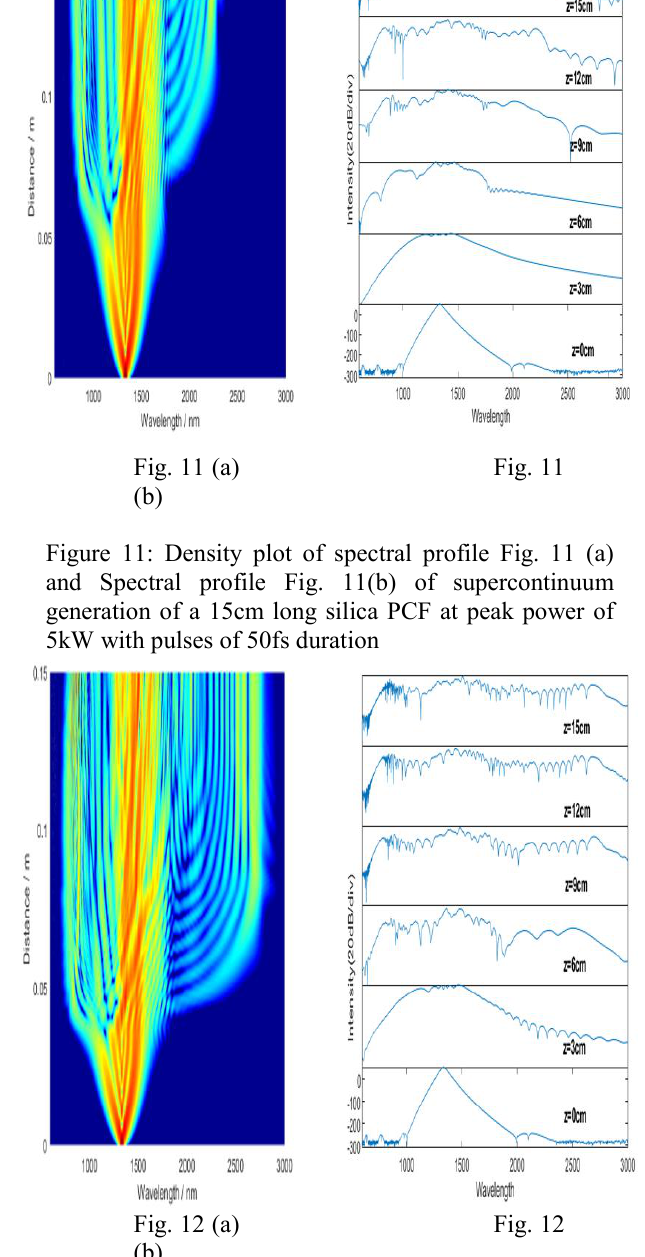
Figure 12: Density plot of spectral profile Fig. 12 (a) and Spectral profile Fig. 12(b) of